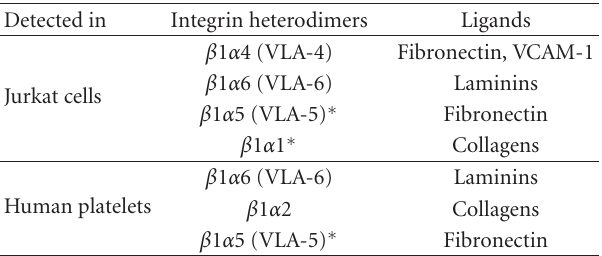
Table 4: Integrin β 1 heterodimers detected in Jurkat cells and human platelets. ∗ Only detected in one